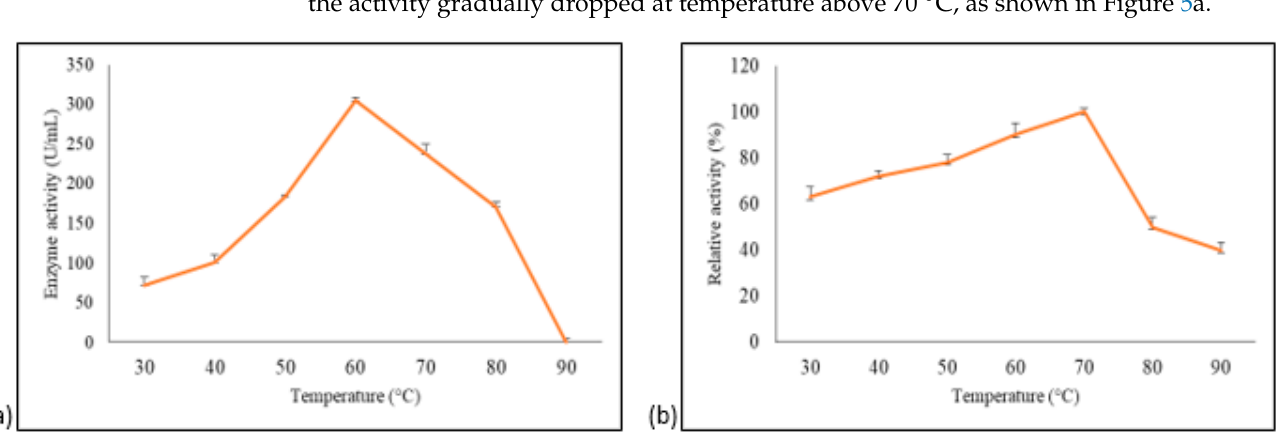
Figure 5. Temperature optimum and stability of the purified A. geothermalis ALDH. ( a ) Effect of temperature on the activity of aldehyde dehydrogenase. ( b ) Effect of temperature on the stability of aldehyde dehydrogenase.